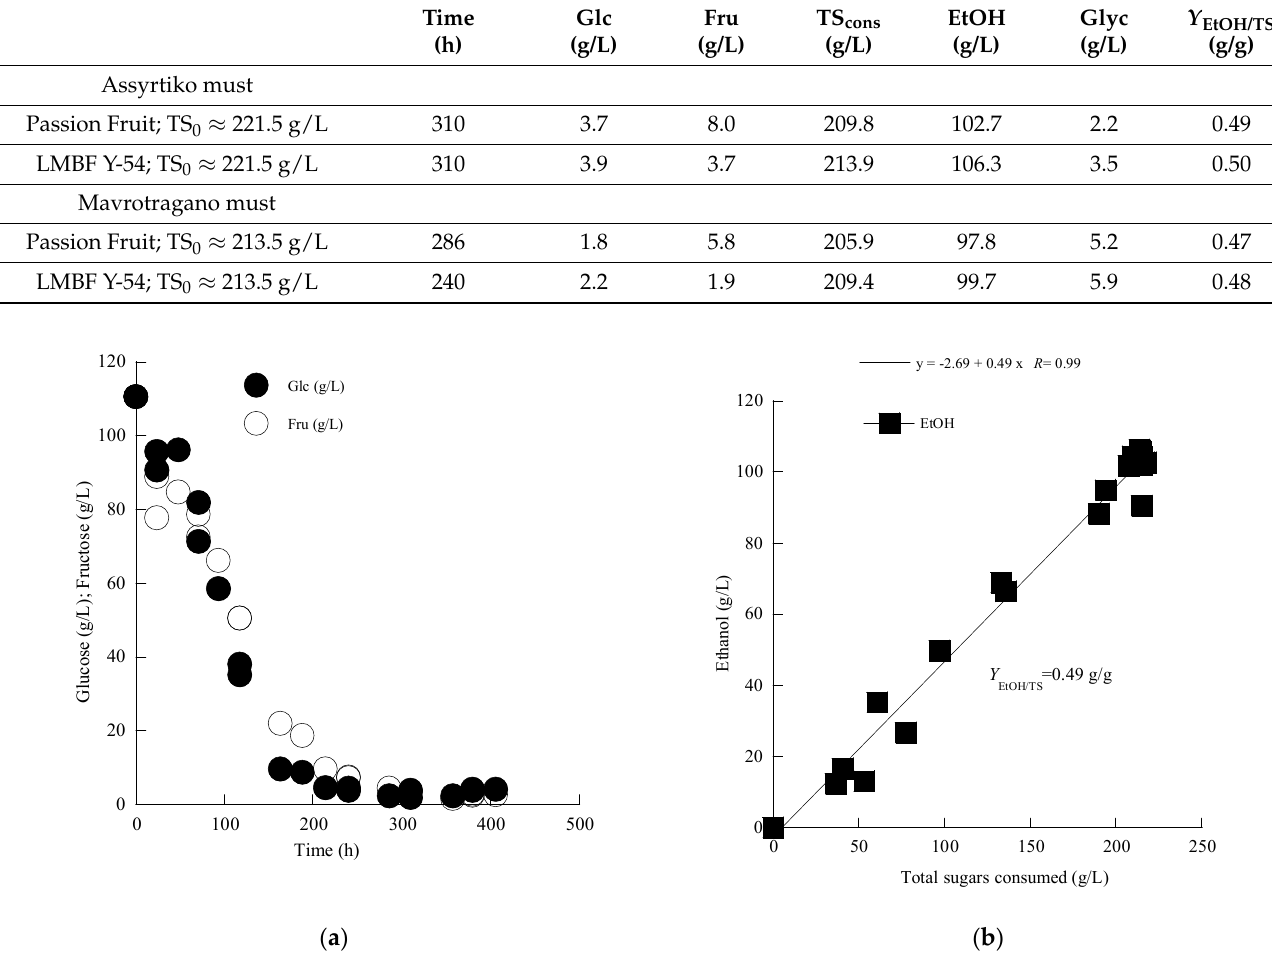
Figure 1. ( a ) Kinetics of glucose (Glu) and fructose (Fru) of the S. cerevisiae LMBF Y-54 strain in must from the grape variety Assyrtiko. Each experimental point is the mean value of 2 independent measurements (SE for most experimental points ≤ 17%). ( b ) Representation of ethanol produced vs. total sugars consumed of S. cerevisiae strain LMBF Y-54 in must from the grape variety Assyrtiko. for the whole set of data. Each experimental point is the mean value of 2 independent measurements (SE for most experimental points ≤ 17%).